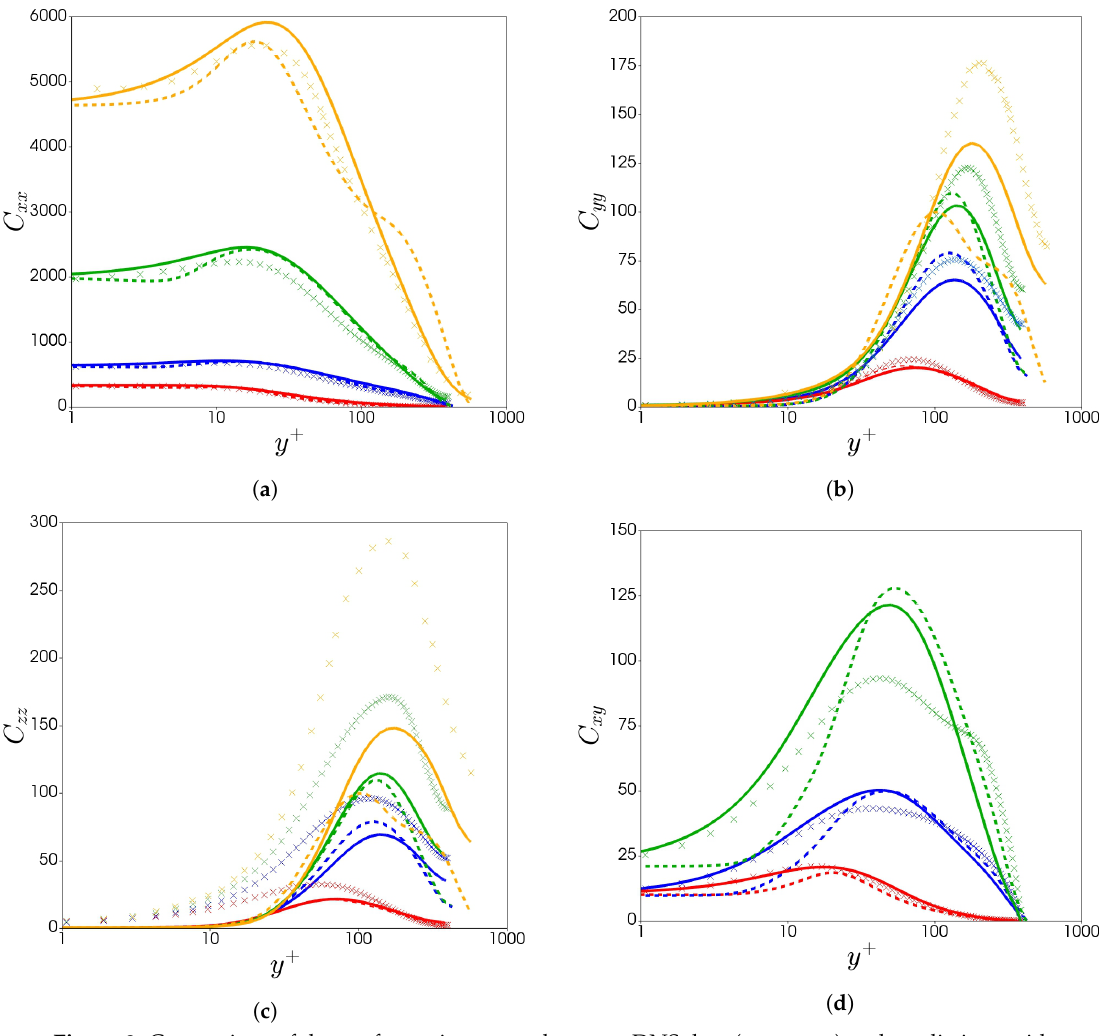
Figure 3. Comparison of the conformation tensor between DNS data ( × crosses) and predictions with the new model (continuum lines), and previous model (dash lines): ( a ) C xx ; ( b ) C yy ; ( c ) C zz and ( d ) C xy . Each colour represents a different drag reduction regime: red (LDR, case 16); blue (IDR, case 19); green (HDR, case 20) and orange (very HDR, case 26. DNS data not available for C xy